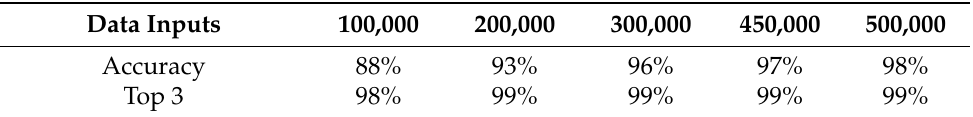
Table 1. Influence of data inputs on model accuracy without base demand variation for the Net3 network with an emitter coefficient range of 5–15.